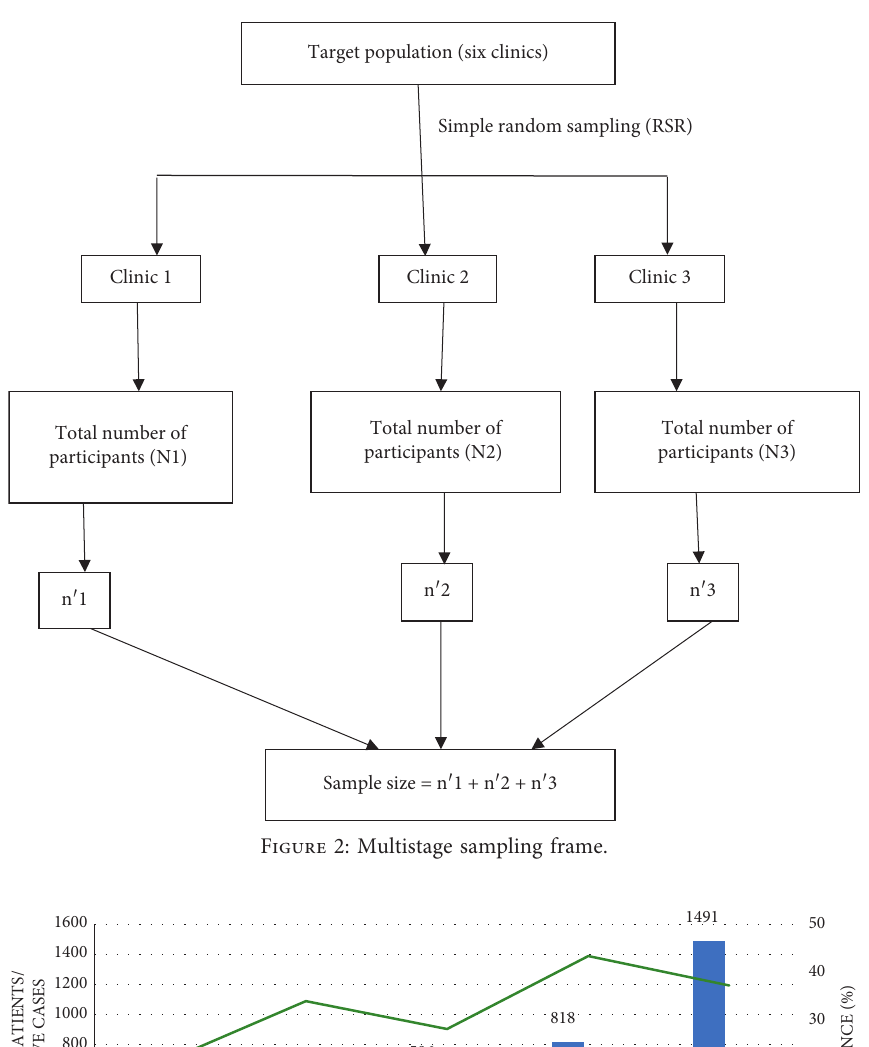
Figure 2: Multistage sampling frame.